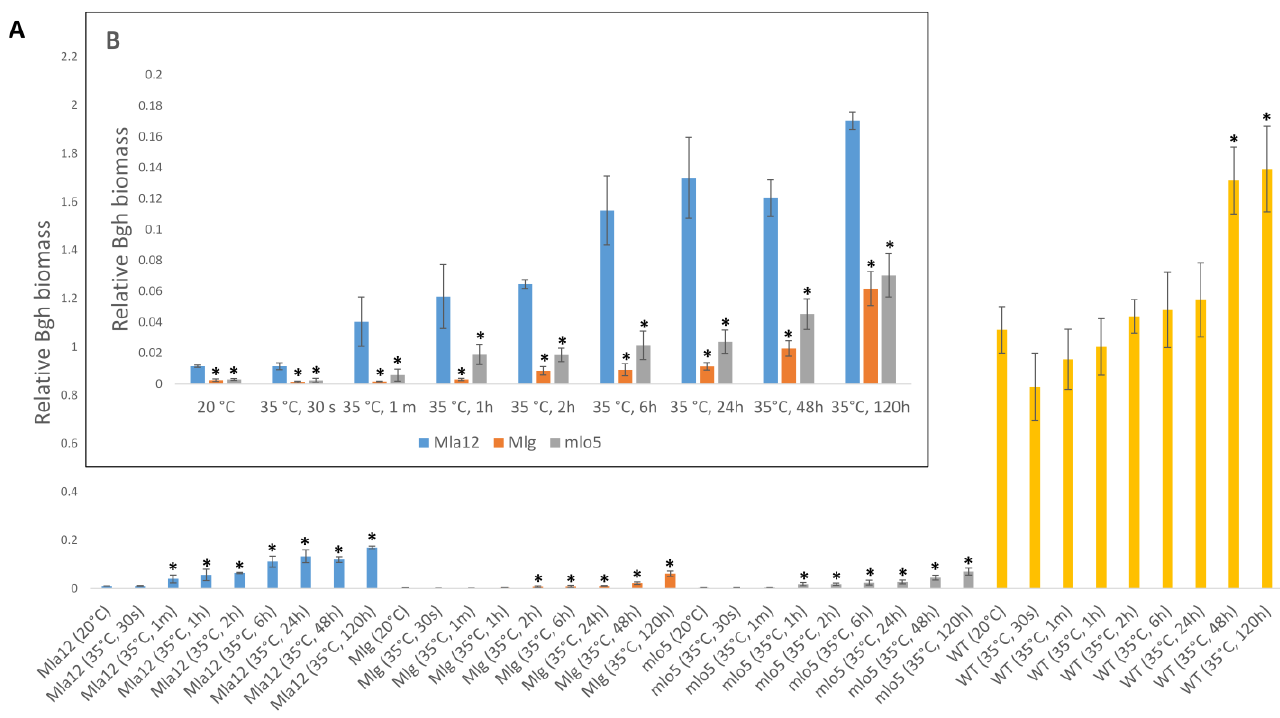
Figure 3. Relative powdery mildew ( Blumeria graminis f. sp. hordei A6, Bgh) biomass ( A ) in resistant (Mla12, Mlg, mlo5) and susceptible (WT) lines of Hordeum vulgare cv. Ingrid seven days after inoculation. Barley plants were exposed to high-temperature stresses (35 °C) for different periods of time (30 s to 120 h) before powdery mildew inoculation. Control plants were kept at 20 °C. The graphs show the average of three experiments. Error bars represent standard deviation. Asterisks ( * ) indicate statistically significant differences between non-heat-treated and heat-treated plants within the respective barley genotypes at p < 0.05. ( B ) Relative Bgh biomass in resistant lines (Mla12, Mlg, mlo5) of H. vulgare cv. Ingrid seven days after inoculation. Asterisks ( * ) indicate statistically significant differences between Mla 12 and the two other resistant lines (Mlg, mlo5) within the respective treatment at p < 0.05.